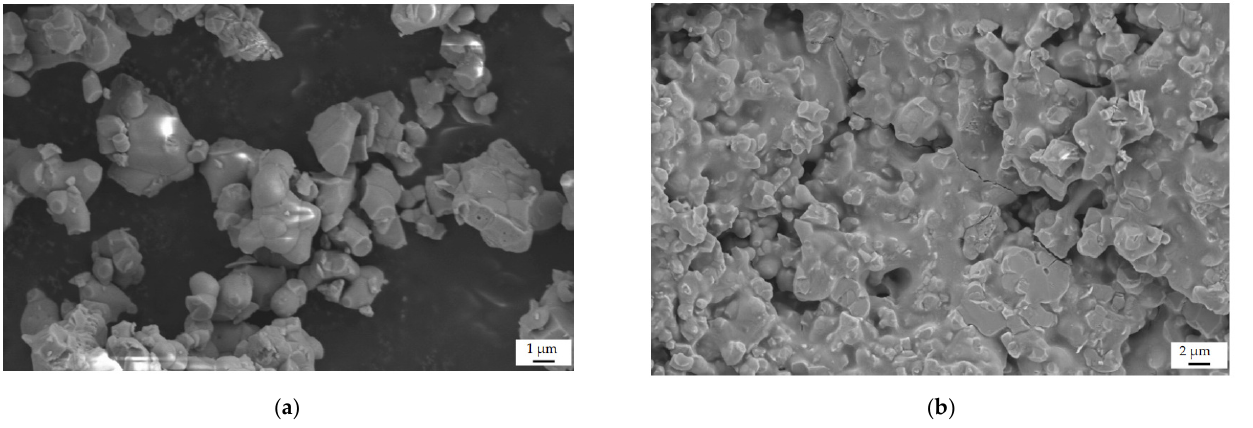
Figure 4. SEM micrographs of the synthetic tricalcium phosphate powder before ( a ) and after mixing with the aqueous solution of sodium silicate (Na 2 O · 2,87SiO 2 ) aq and drying at 60 °C for 24 h ( b ).